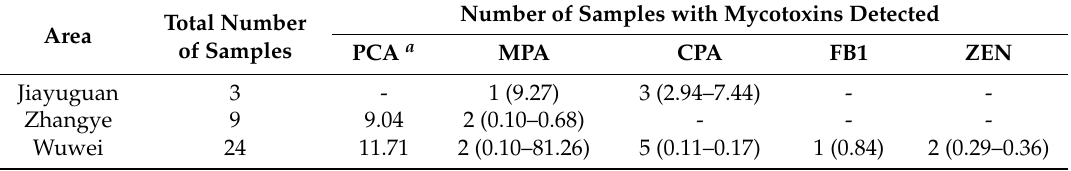
Table 5. Contamination levels of investigated mycotoxins in test grape samples with their frequency of occurrence and concentration ranges ( µ g/L).